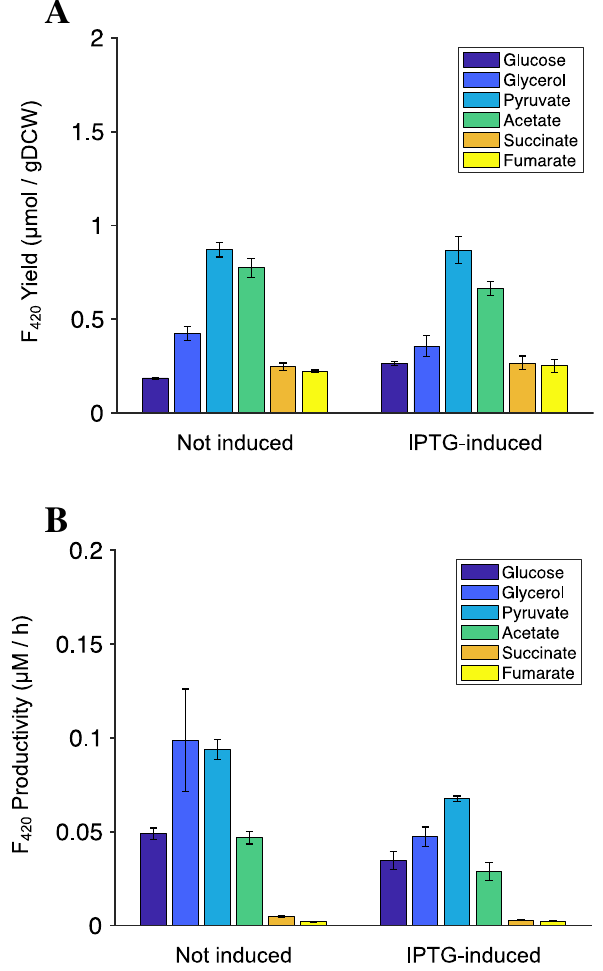
Figure 7. Effect of PPCK over-expression on ( A ) F 420 yield with and without IPTG (0.1 mM) induction; ( B ) F 420 productivity (µM/h) with and without IPTG (0.1 mM). Leaky expression of PPS was observed without the addition of IPTG (Supplementary Fig. S3). E. coli was cultivated in a minimal media with different sole carbon sources as shown. Error bars show standard errors of the mean of at least two